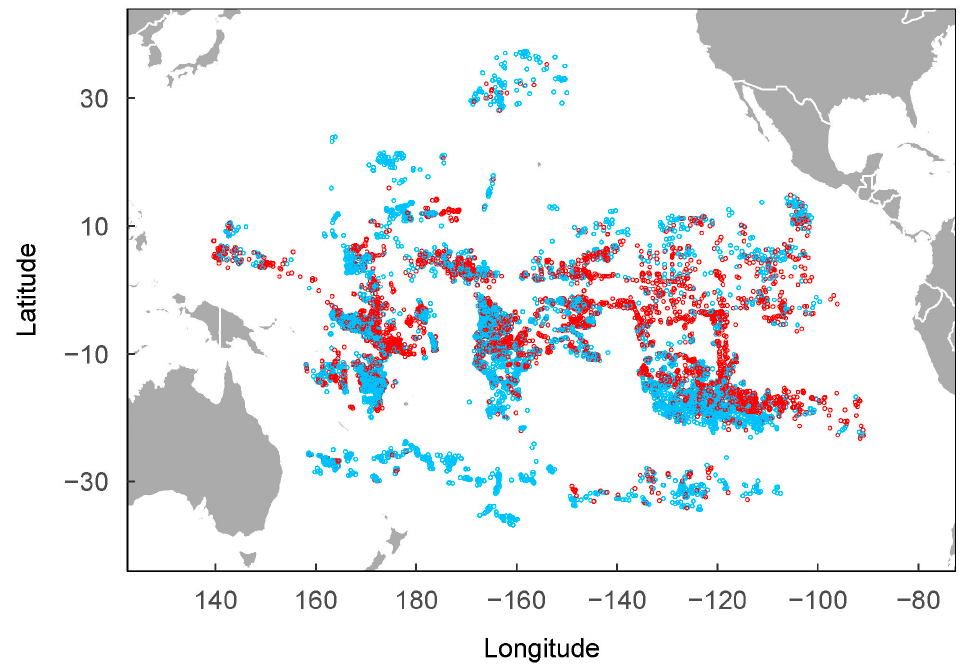
Figure 1. Observed sets of tuna longline fishery from 2016 to 2019. The red dots represent the observed presence of P. violacea , and the blue dots represent the observed absence of P. violacea .